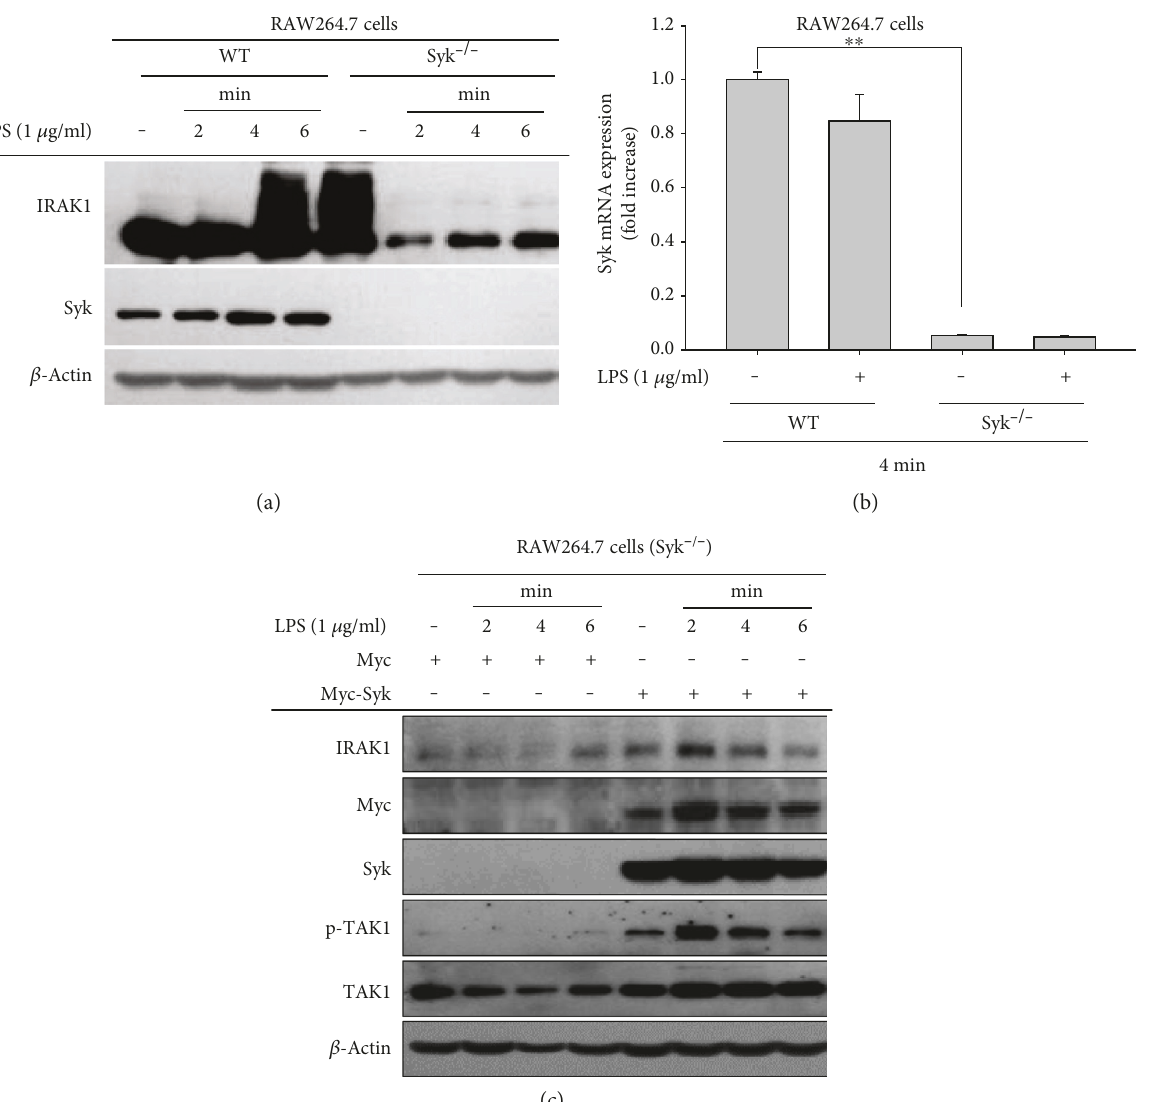
Figure 2: Syk impacts the regulation of IRAK1 activation in LPS-treated RAW264.7 cells. (a and c) Total or phospho-protein levels of IRAK1, Syk, Myc, TAK1, and β -actin as determined by lysate immunoblotting prepared from LPS- (1 μ g/ml) treated RAW264.7-WT, RAW264.7-Syk − / − cells, or RAW264.7-Syk − / − cells transfected for 24 h with Myc-tagged Syk (5 × 10 6 cells/ml). (b) Syk mRNA levels from RAW264.7-WT or RAW264.7-Syk − / − cells treated with LPS (1 μ g/ml) as determined using real-time PCR. All data are expressed as the mean ± SD of three independent replicate